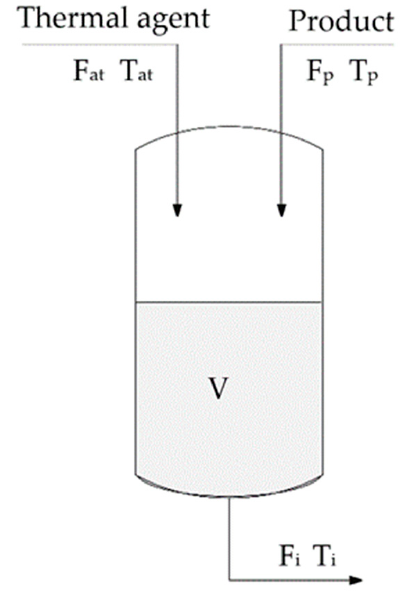
Figure 1. Schematic of a process with temperature control.